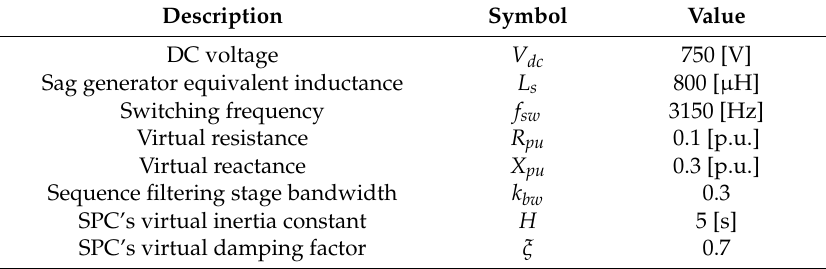
Figure 5. The 100 kW grid-connected power converter simulation test system. Table 1. Key parameters of the 100 kW SPC-based power converter.